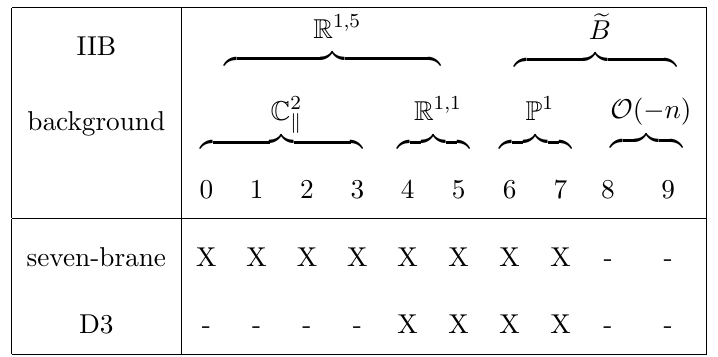
Figure 2 . IIB description of the tensor branch of the 6d (1,0)